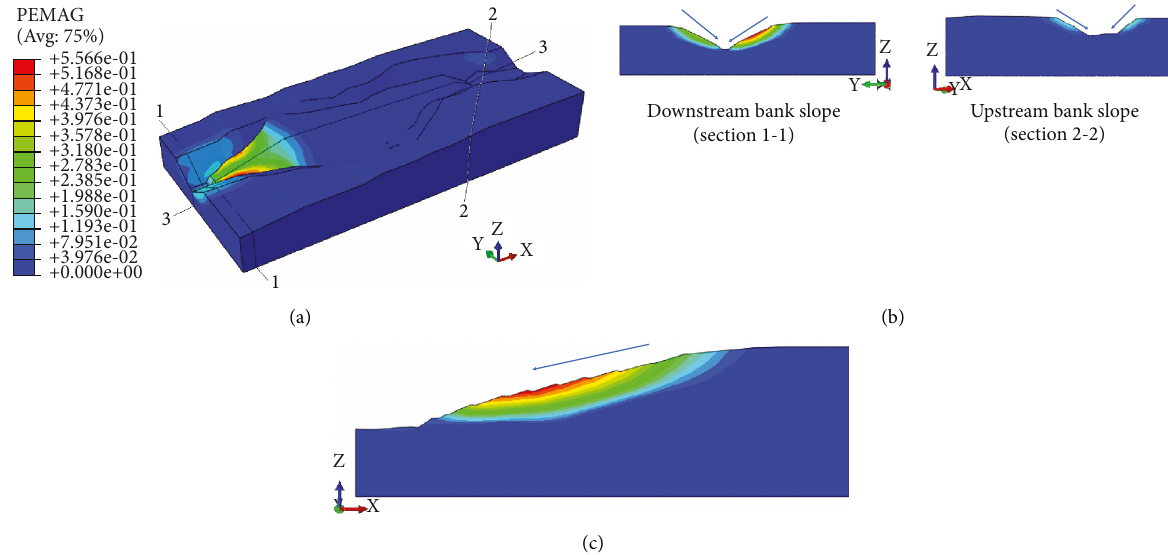
Figure 16: (a) The plastic zone of critical buckling destruction of landfill slope in Scheme 7 (safety factor is 1.457). (b) The landslide form section of critical buckling destruction of bank slope in Scheme 7 (the deformation scale factor is 2). (c) The landslide form section of critical buckling destruction of waste pile slope in Scheme 7 (section 3-3) (the deformation scale factor is 2).